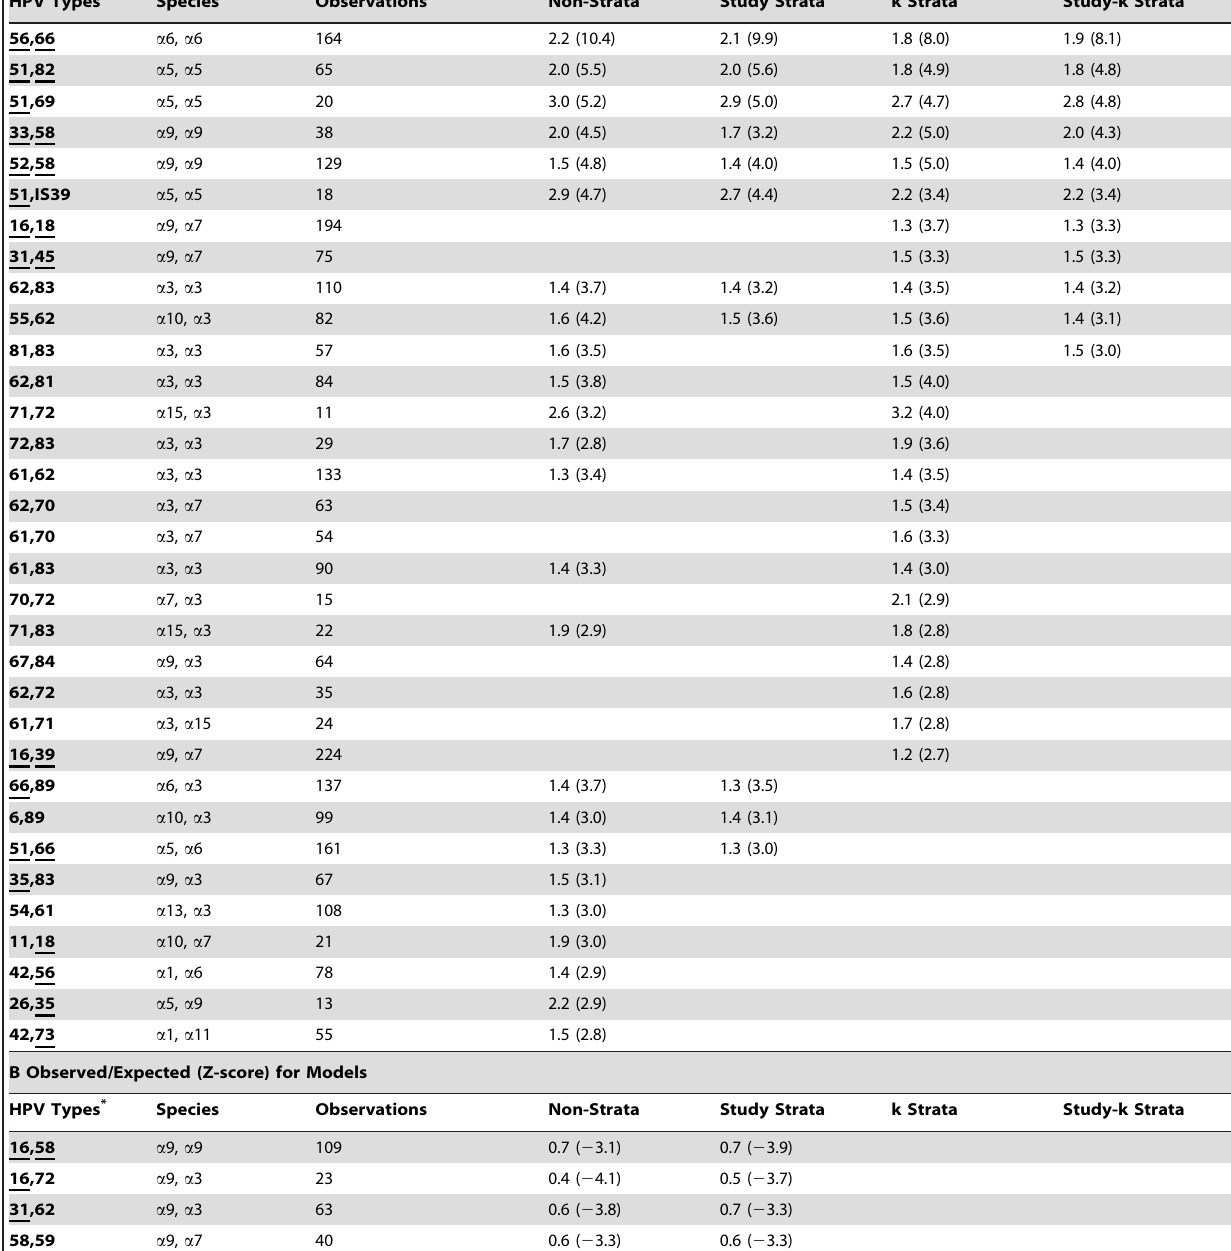
A Observed/Expected (Z-score) for